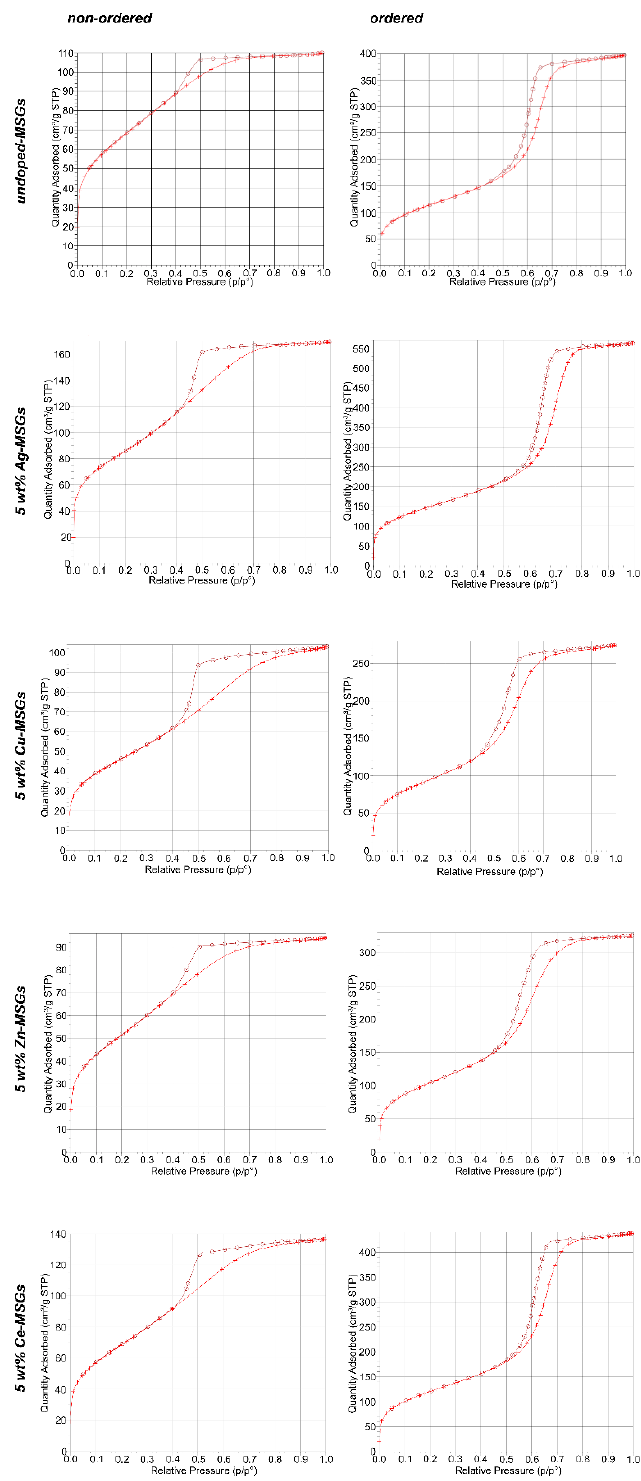
Figure 4. N 2 adsorption-desorption isotherms of non-ordered and ordered, undoped-MSGs, 5 wt% Ag-MSGs, 5 wt% Cu-MSGs, 5 wt% Zn-MSGs, and 5 wt% Ce-MSGs. Crosses ( + ) and open circles (O) represent the adsorption and desorption branches, respectively.